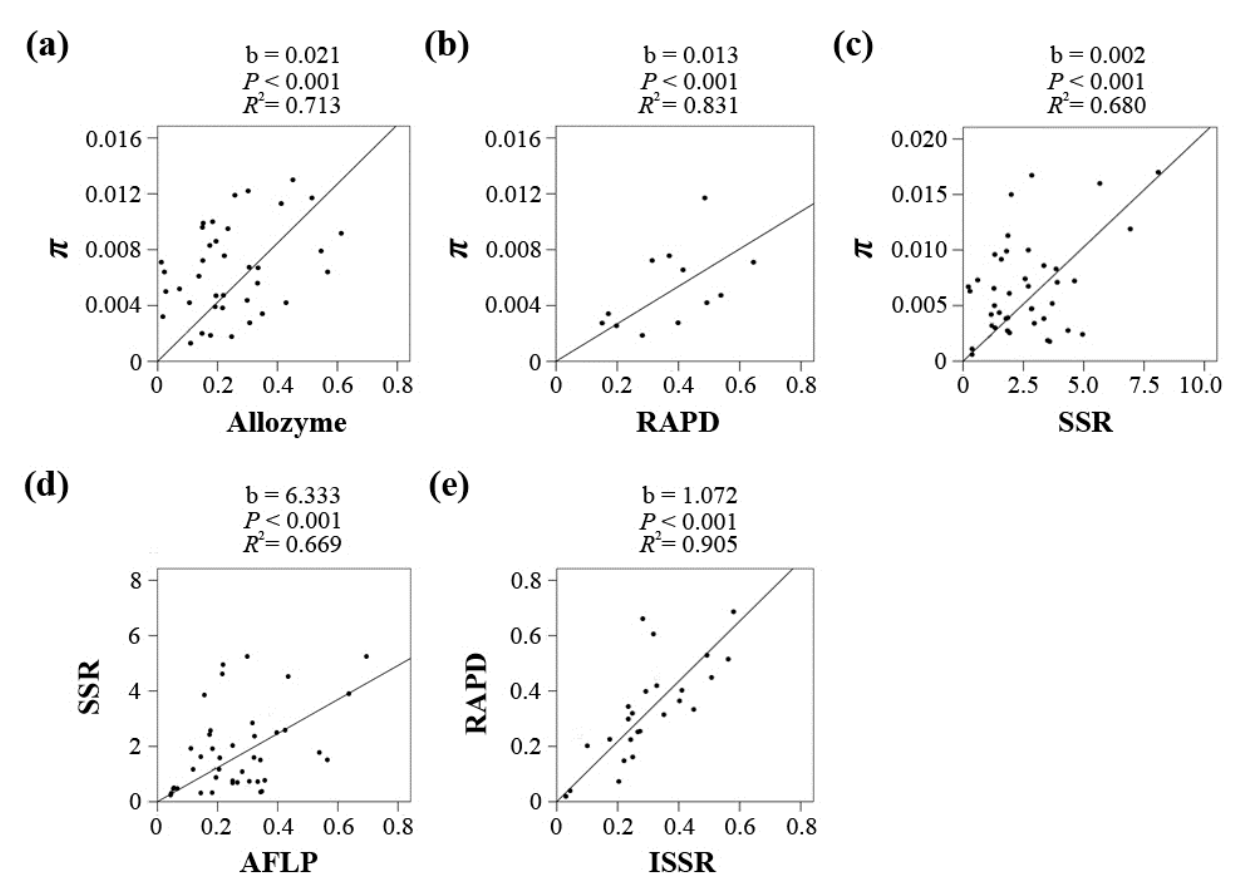
Figure 2. Regression results for each of the five marker pairs using a linear model without intercept, including Sequence/Allozyme ( a ), Sequence/RAPD ( b ), Sequence/SSR ( c ), SSR/AFLP ( d ) and RAPD/ISSR ( e